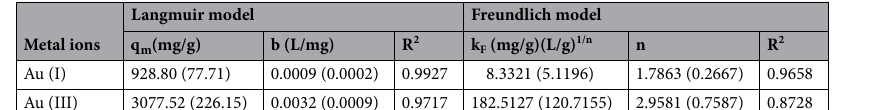
Langmuir model Freundlich model Metal ions